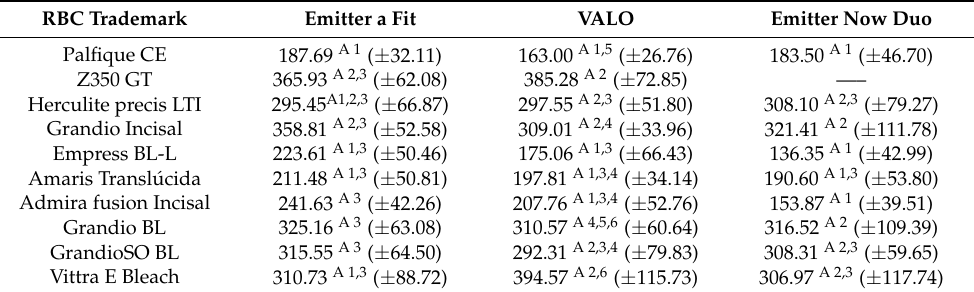
Table 6. Mean and standard deviation of the biaxial flexure strength test (in Newtons (N)) of each resin-based composite (effects shade) cured with LED units from the second and third